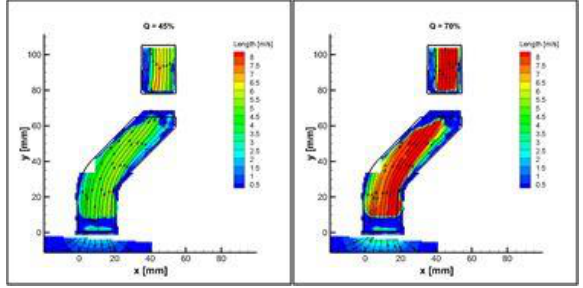
Fig. 14. Velocity field evaluated for channel No. 1 and two flow values.